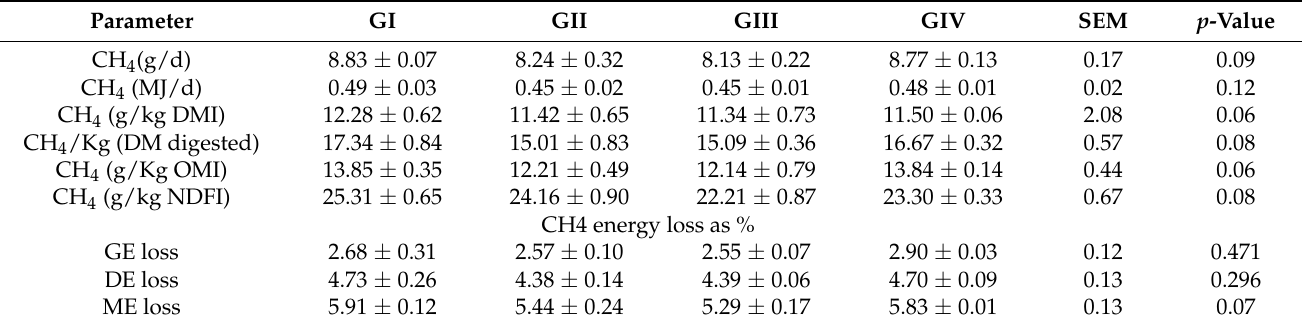
Table 6. Enteric methane emissions of male kids in different groups fed with replacement of concen- trate with Moringa oleifera